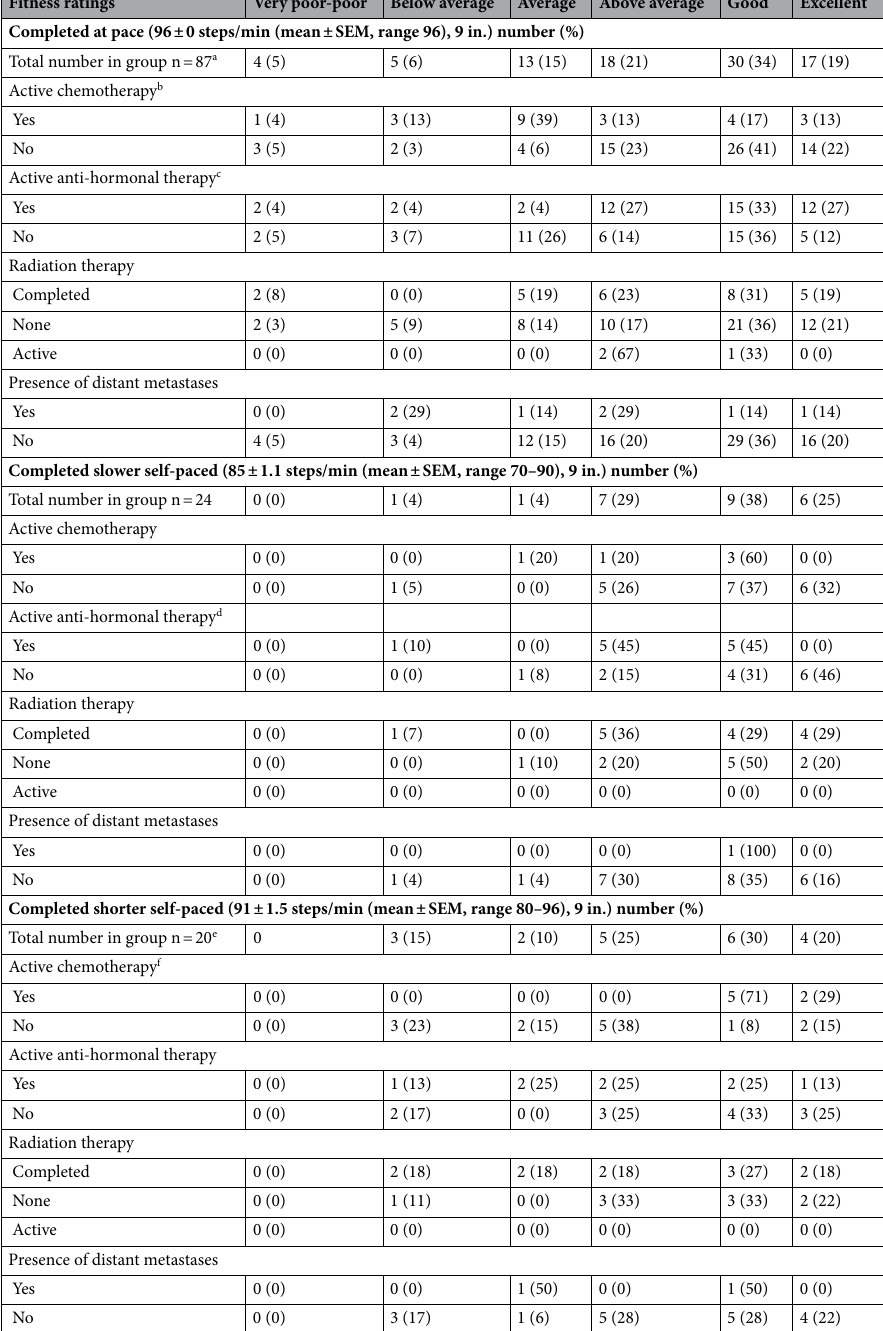
Table 5. Fitness ratings. a N = 1 excluded from analyses for exercise-induced arrhythmia. b p = 0.0018, Fisher’s exact, two-tailed. c p = 0.0347, Fisher’s exact, two-tailed. d p = 0.0238, Fisher’s exact, two-tailed. e N = 1 excluded from analyses as pulse recovery not determined. f p = 0.0103, Fisher’s exact,